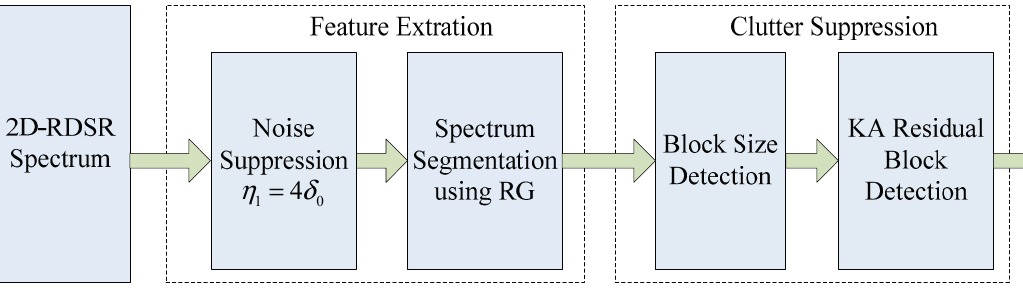
Figure 3. Flowchart of knowledge-aided (KA) image feature-based moving targets detection.